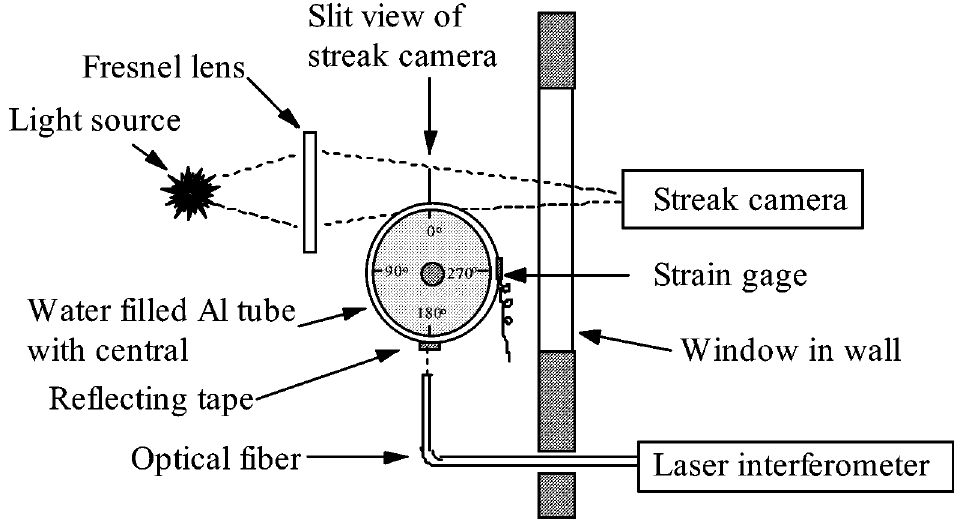
Fig. 2. Top view of instrumented apparatus at the tube’s mid-height